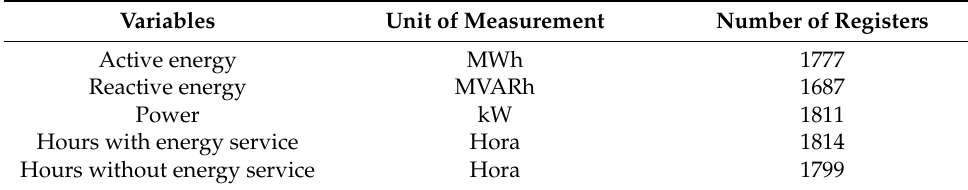
Table 1. Dataset